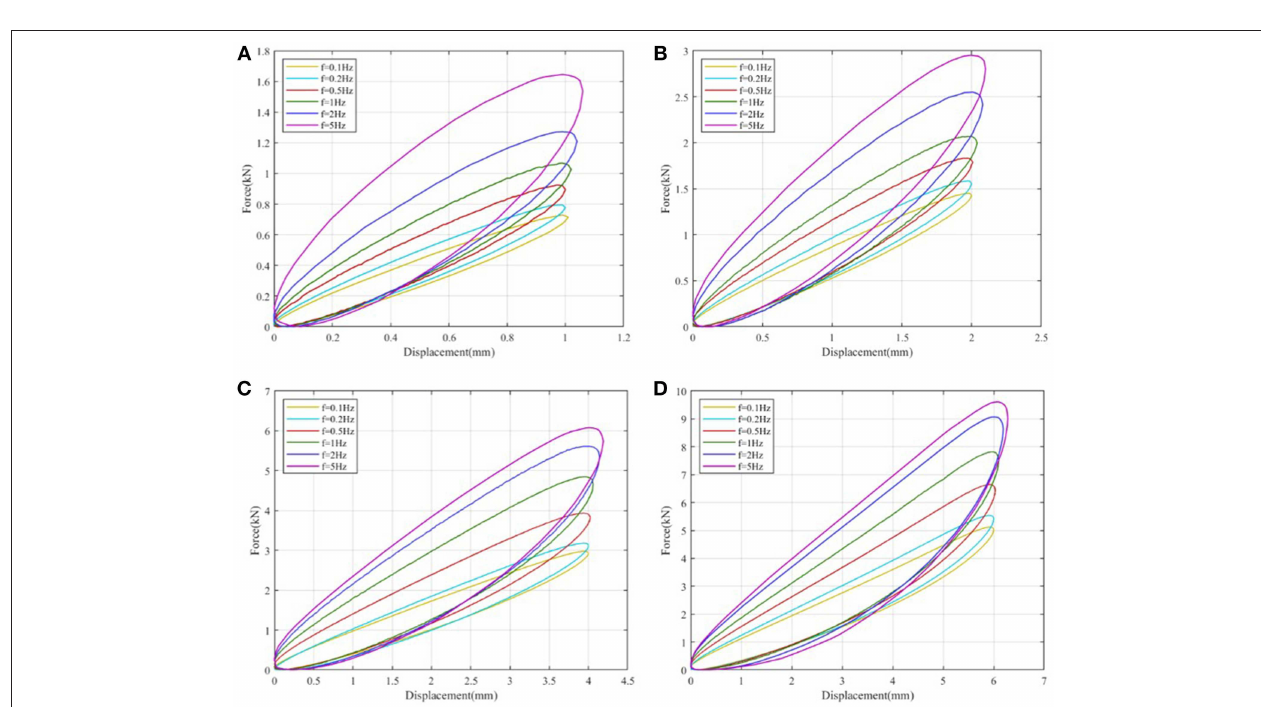
FIGURE 8 | Hysteretic curves under different frequencies and displacement amplitudes. (A) 1mm, (B) 2mm, (C) 4mm, (D) 6mm.